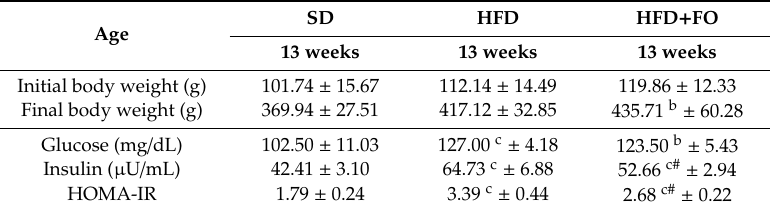
Table 2. Body weight, fasting plasma glucose and insulin concentration, and HOMA-IR value in Wistar rats fed with di ff erent types of diets. SD HFD HFD + Age